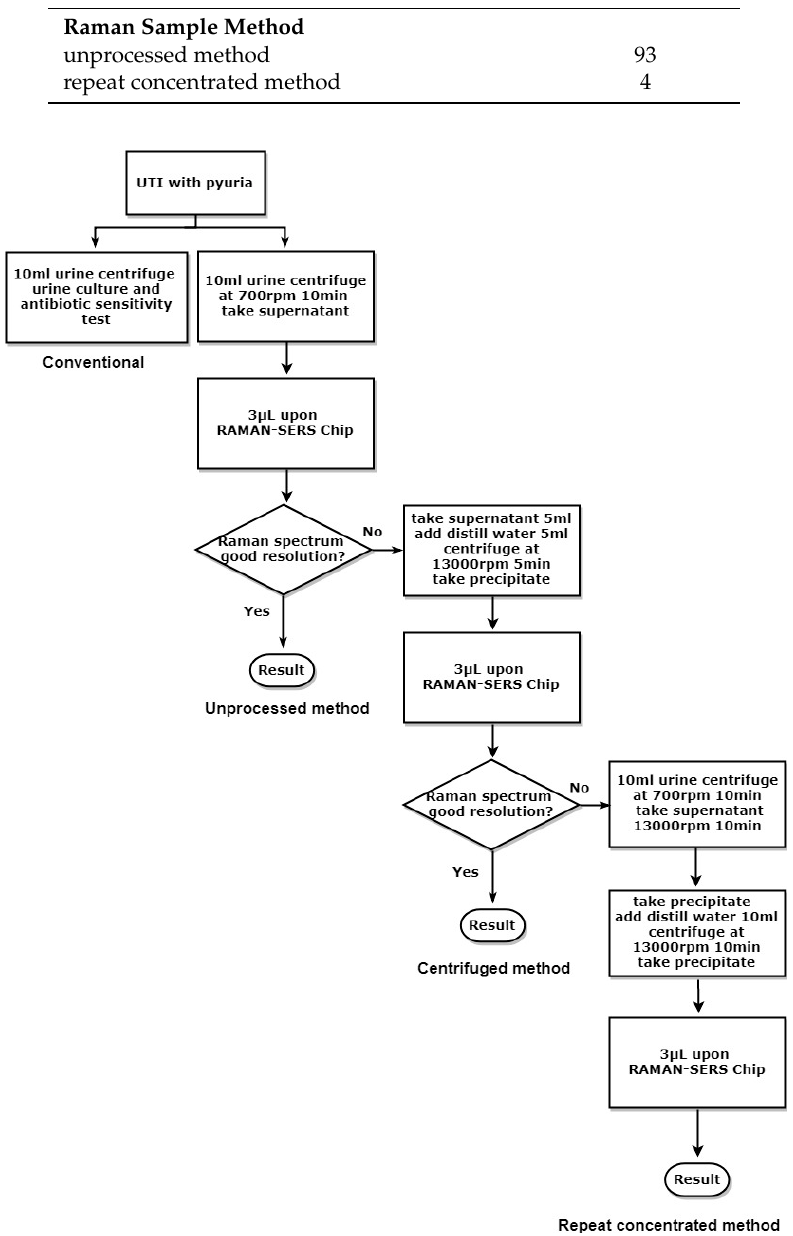
Figure 1. Flowchart of urine-sample processing.